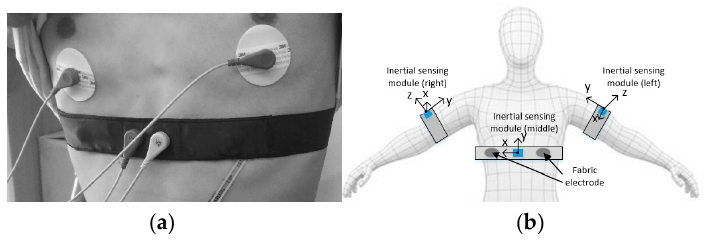
Figure 1. ( a ) Wearable chest strap; ( b ) inertial sensor module position.